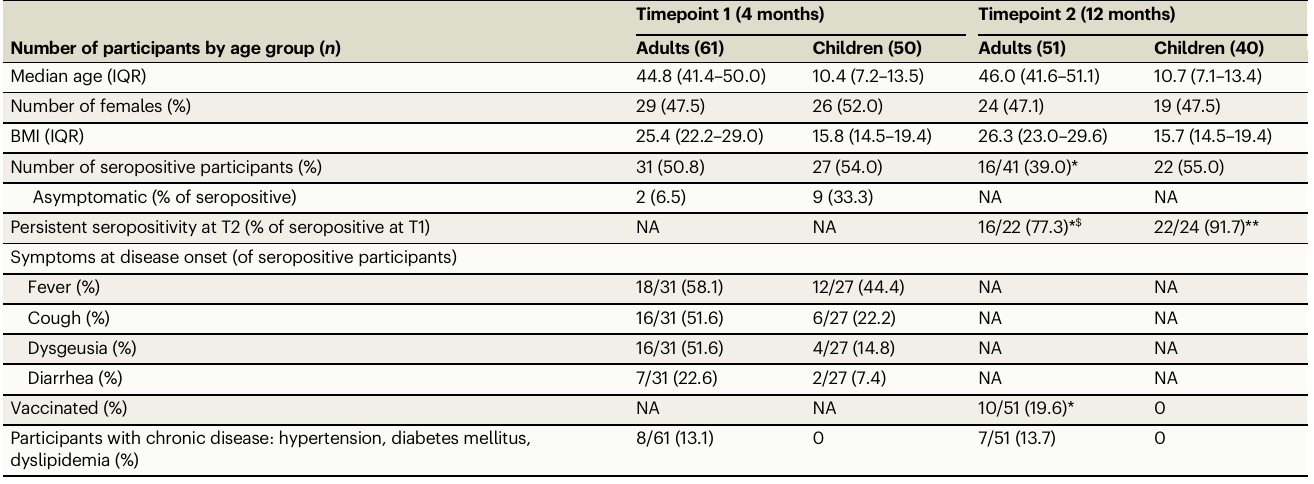
Table 1 | Demographics and key information on the study